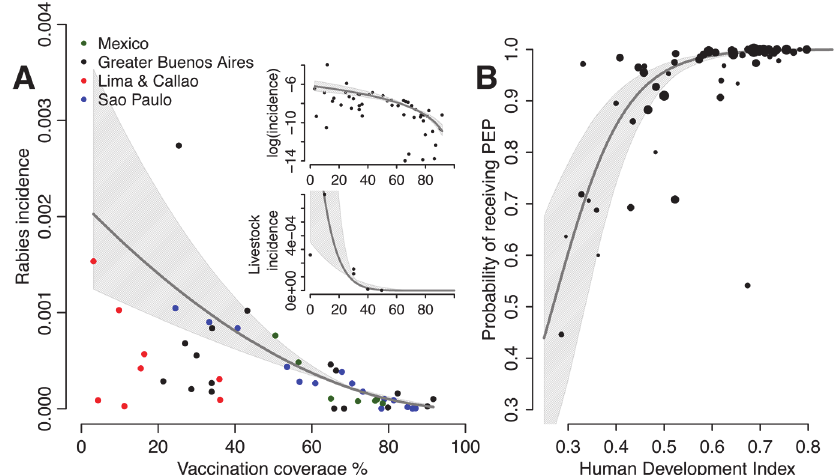
Fig 2. Functional relationships estimated between A) rabies incidence in domestic dogs and average biannual dog vaccination coverage and B) probability of receiving post-exposure prophylaxis (PEP) and the Human Development Index. Upper inset in A shows the relationship on a log scale and the lower inset shows the relationship between rabies incidence in livestock and vaccination coverage in domestic dogs. Grey shading shows the 95% confidence intervals of the fitted